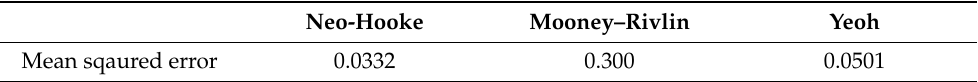
Figure 7. Representative stress–strain curve of the SBR filled with 70 phr N234 measured in compression mode and the corresponding simulated curves using neo-Hooke (NH), Mooney–Rivlin (MR) and Yeoh (Y) models derived from measurement performed in tensile. Table 5. Mean squared error of the measurement curve in compression and the fit curves using neo-Hooke, Mooney–Rivlin and Yeoh models.